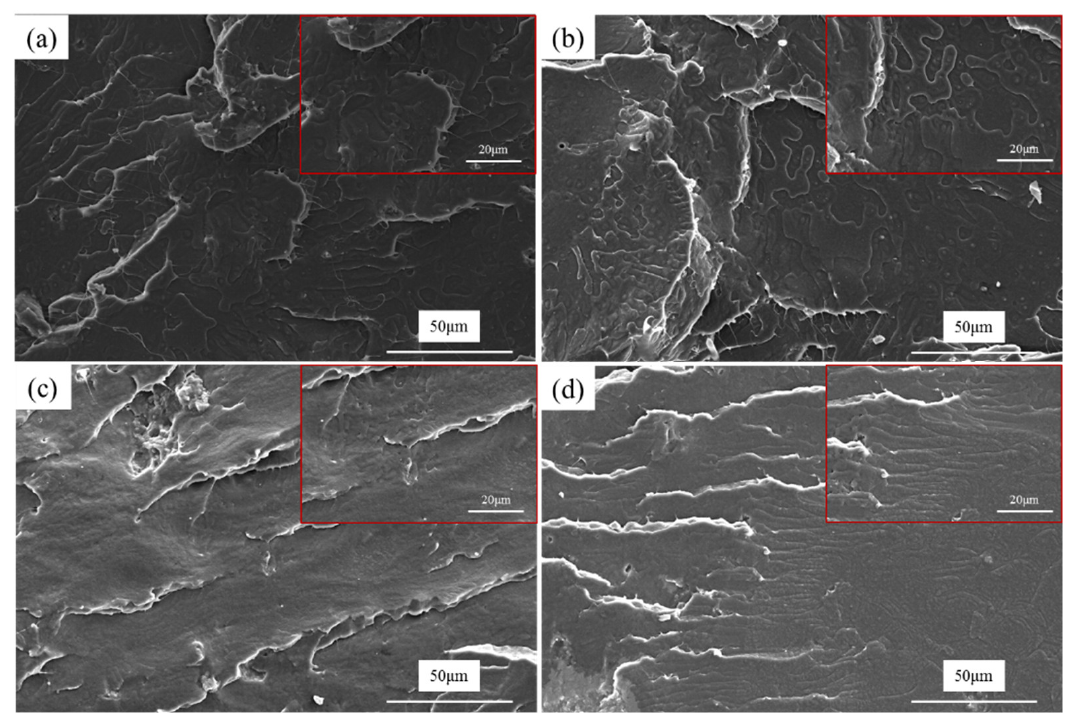
Figure 9. SEM micrographs of the impact fracture surfaces for PLA/GTR (95/5) blends with different DCP content: ( a ) 0 wt.%; ( b ) 0.2 wt.%; ( c ) 0.6 wt.%; ( d ) 1.0 wt.%.